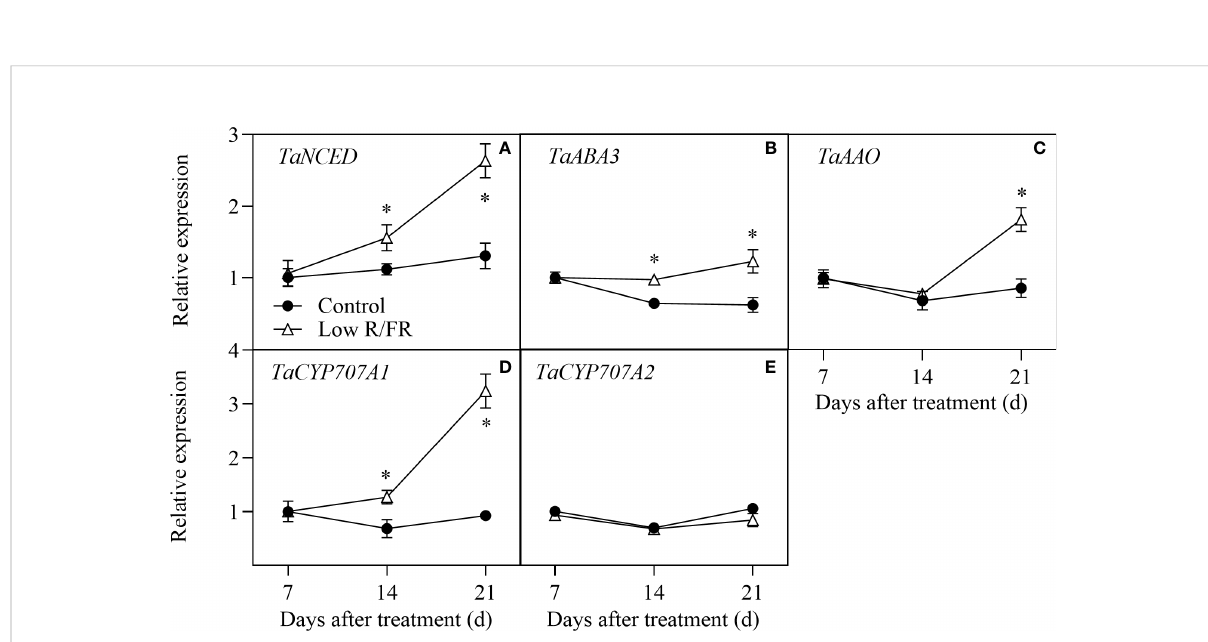
FIGURE 3 Expression of ABA metabolism genes in the tiller IV under control and low R/FR conditions. Relative transcript levels of TaNCED (A) , TaABA3 (B) , TaAAO (C) , TaCYP707A1 (D) , and TaCYP707A2 (E) in the tiller IV treated for 7, 14 and 21 d. Data are the means of three biological replicates ± SE, and the asterisk denotes a statistically remarkable difference ( P < 0.05) between treated and control samples.